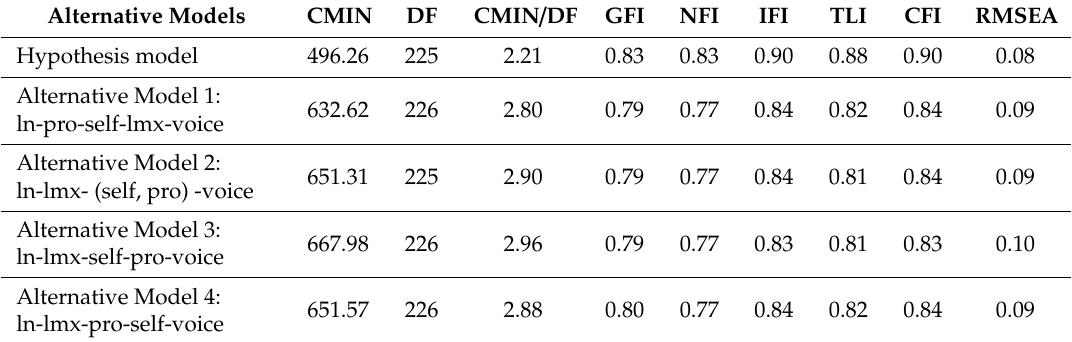
Table 3. Results of structure model and comparing